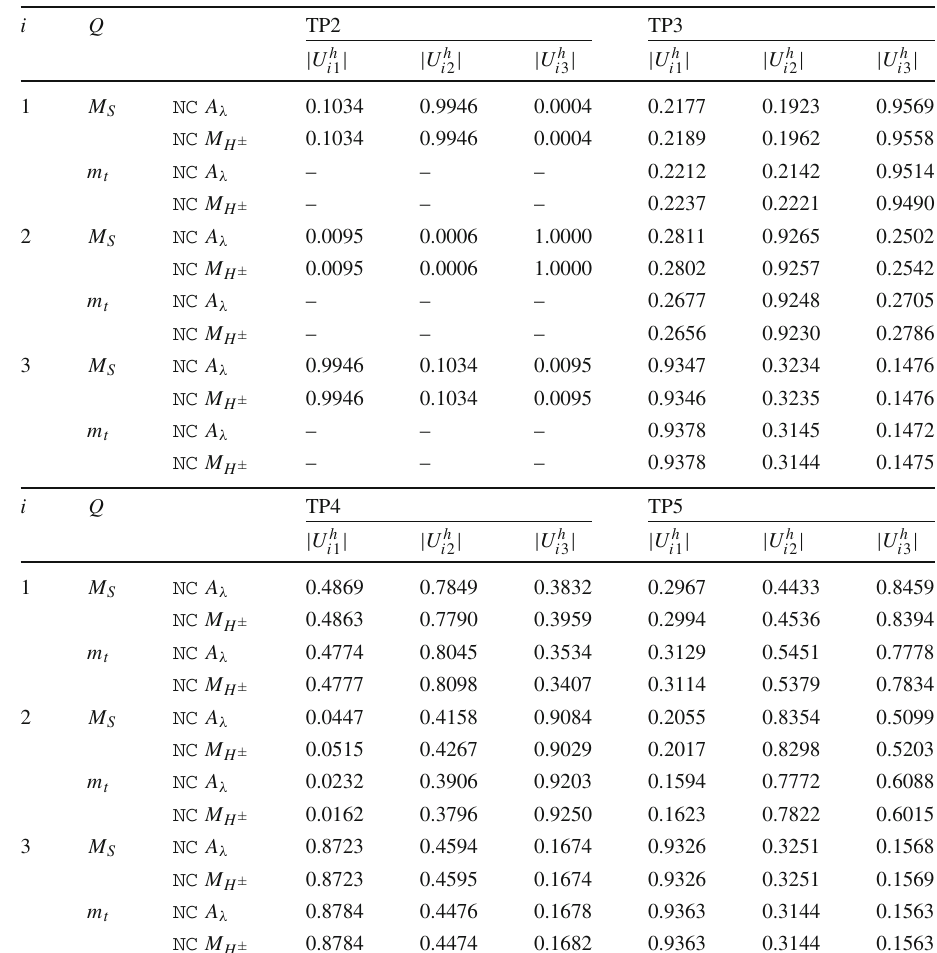
the mixing-matrix elements of the CP -even scalar sector for TP2–TP5 when using the DR renormalization of the top/stop sector for either A λ as input or M H